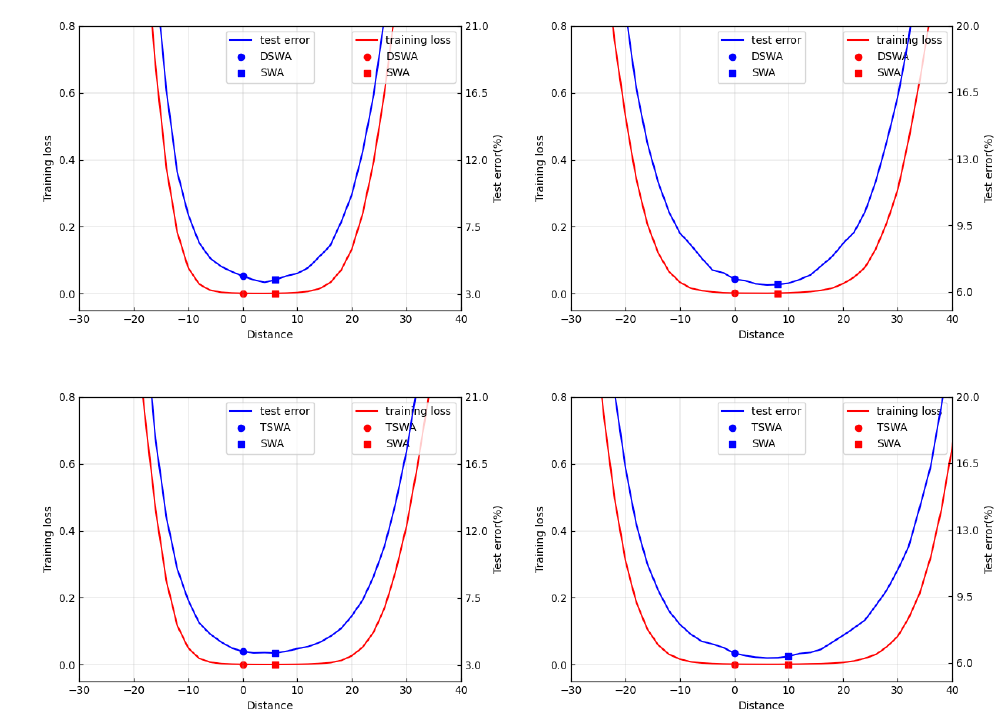
Figure 6. Cross-entropy training loss and testing error as a function of a point on the line connecting the SWA and DSWA (or TSWA) solutions on CIFAR-10. DSWA and TSWA were initialized by a converged preceding SGD procedure. Left: PreResNet-164. Right: